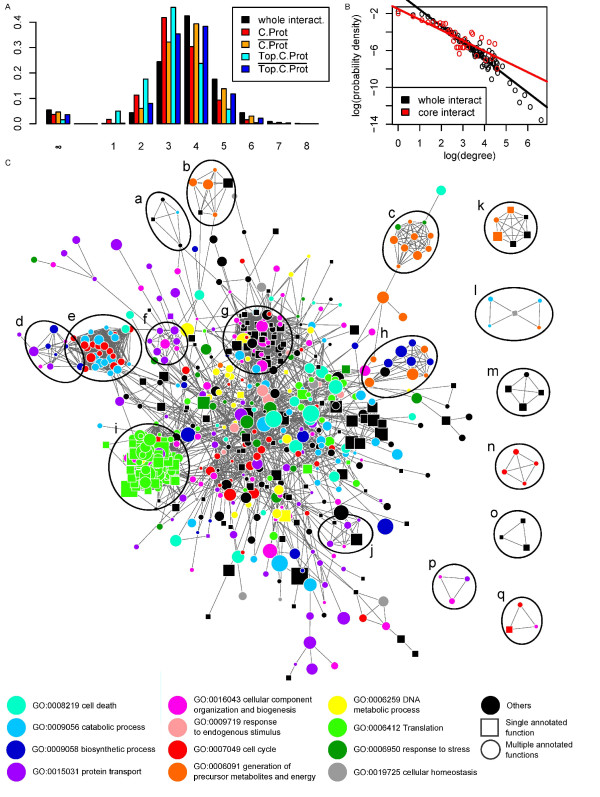
The central interactome. (A) Shortest path distance distributions. We first remark that distances between C.Prot entities (red) are closer than distances between proteins of the human interactome (black), i.e. short distances below 4, which is the mean and median distance, are over-represented. Remarkably, C.Prot is also closer than on average to the non C.Prot proteins (orange). The abundant C.Prot proteins are even closer to each other and to the non C.Prot proteins (cyan and blue). It shows that C.Prot (and its most abundant components) are embedded "uniformly" in the human proteome. (B) Power law distribution of the whole human interactome versus the central interactome. The central interactome is more connected (exponent -1.1), i.e. frequency of high node degrees decreases slower, than the whole (exponent -1.8). (C) Central interactome with mapped significant biological processes (Table 2). Processes not significantly enriched in C.Prot are in black and multiple GO annotations are depicted by a circle (color chosen randomly) as opposed to a square for single GO. Shared GO term ancestors at a node were removed to eliminate trivial multiple annotations and stay at the most specific levels. We note that, except for a few, processes are not strongly localized in this network. It does not represent juxtaposed pathways but rather an exchange platform. We also observe that most proteins have multiple GO BP annotations (circular node shape), which de facto establish additional exchanges between fundamental cellular processes. Finally, we recognized some important complexes: (a) exosome, (b) ubiquitinol-cytochrome c reducatase, (c) NADH dehydrogenase, (d) oligosaccharyl transferase, (e) proteasome, (f) COPI, (g) ribonucleoprotein/splicosome, (h) proton-transporting ATP synthase, (i) ribosome, (j) signal recognition particle, (k) cytochrome c oxidase subunits, (l) pyruvate/2-oxoglutarate dehydrogenase complex, (m) prefoldin, (n) condensin, (o) Signal peptidase complex, (p) COPII, (q) septin complex. Network visualized with Cytoscape [56].